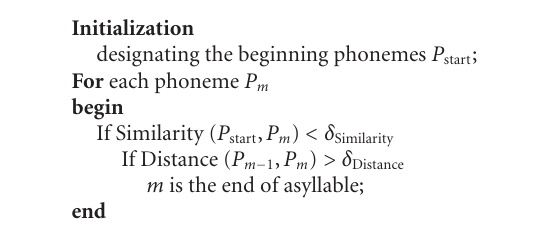
Algorithm 1: Algorithm for syllable extraction.